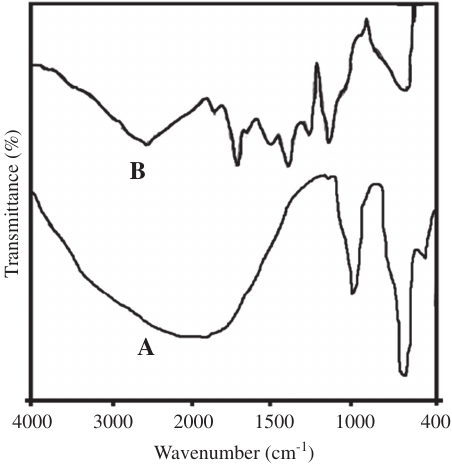
composites for different 3